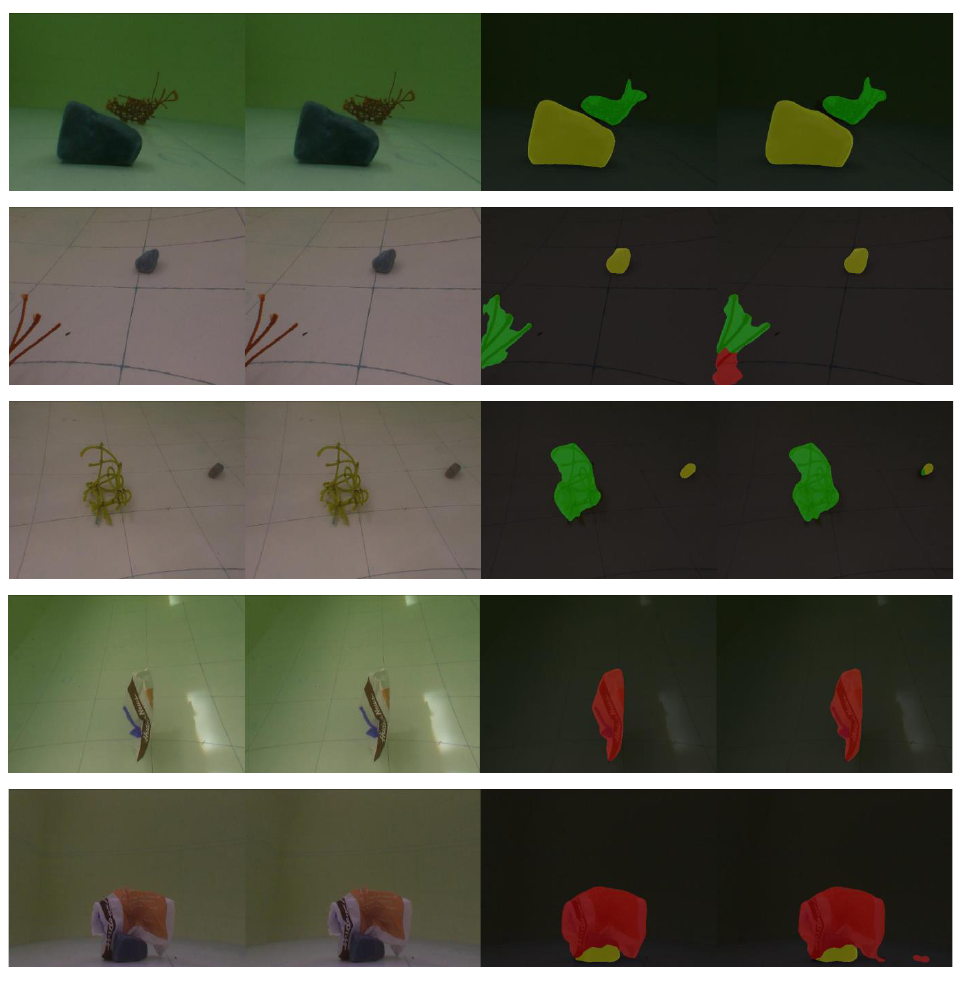
Figure 5. Segmentation results of binocular camera.